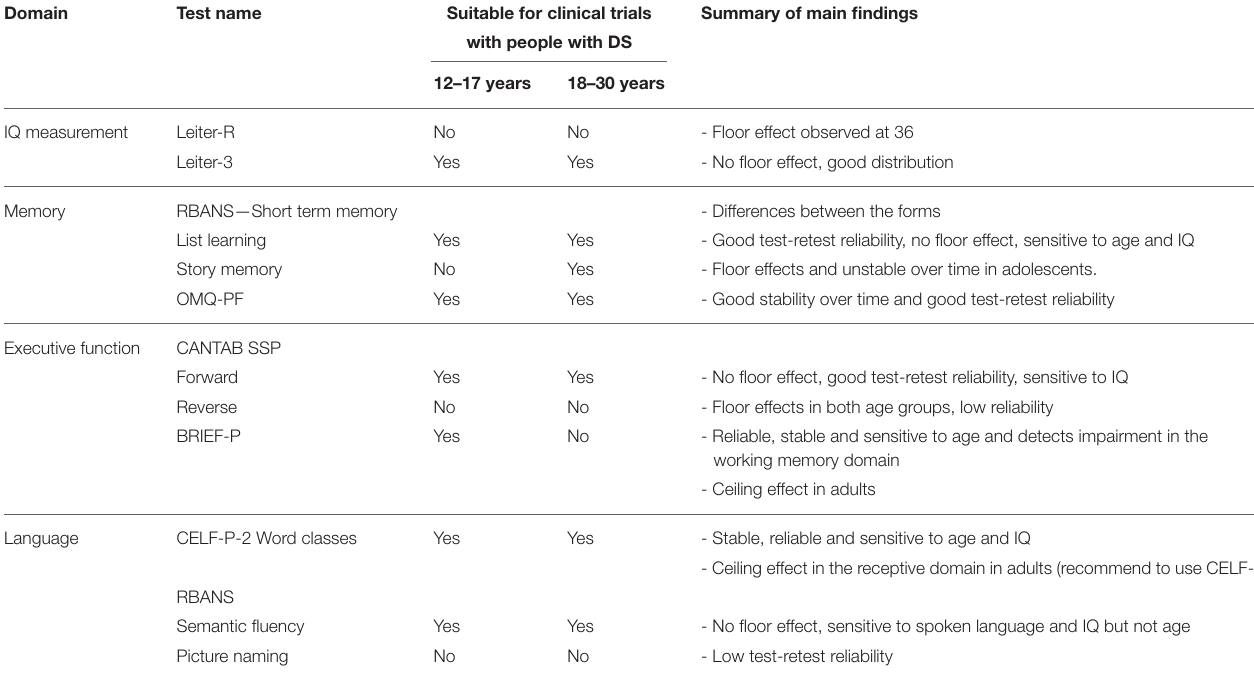
TABLE 6 | Summary of key learnings.